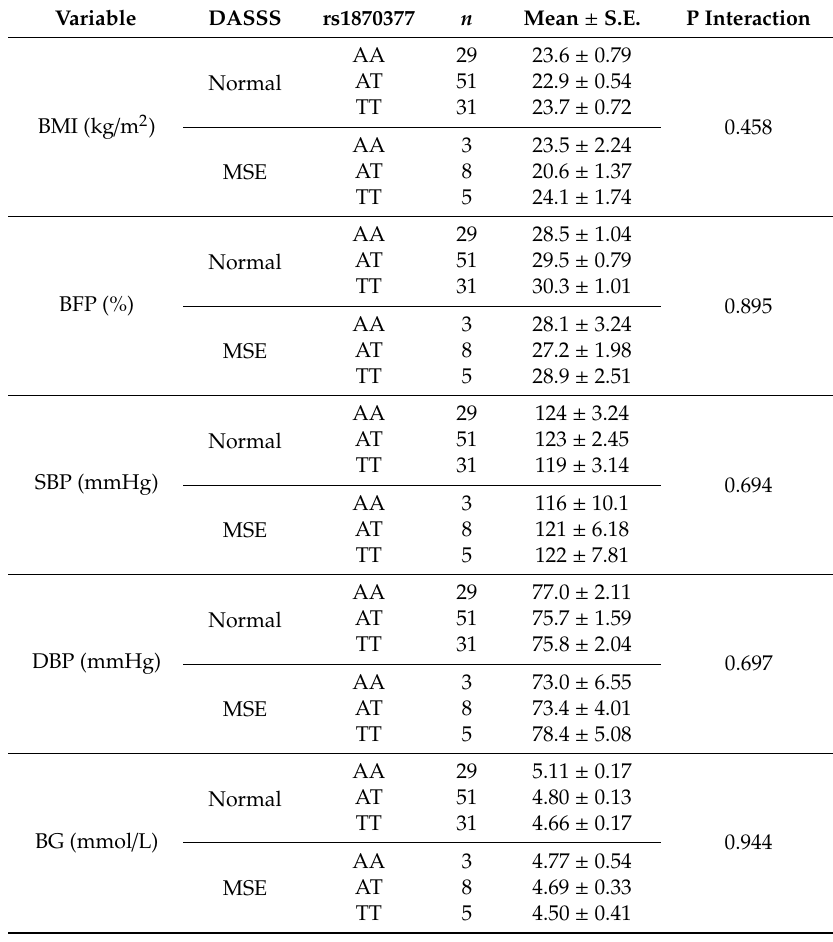
Table 4. Interaction between genotypes of VEGFR-2 gene rs1870377 SNP and categories of Depression, Anxiety, and Stress Scale (DASS) for stress component on cardiometabolic risk